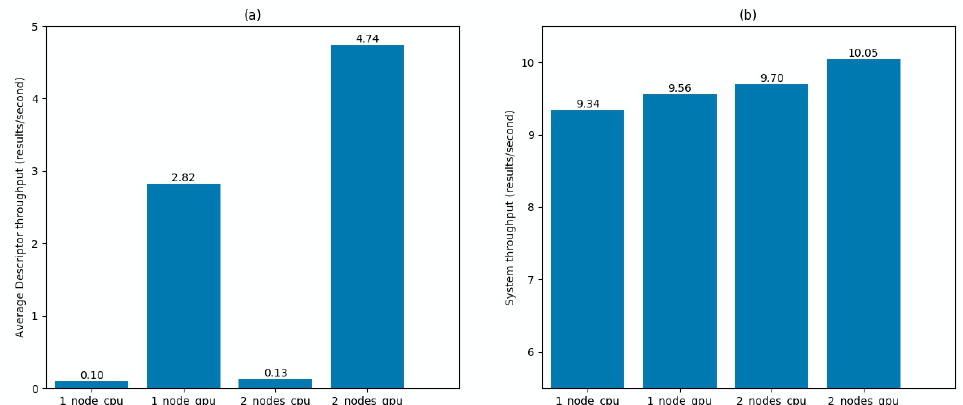
Figure 9. Scalability of six identical Descriptor chains using one or two nodes in both CPU and GPU modes. ( a ) Average Descriptor throughput. It indicates the number of feature updates per second averaged among the six Descriptor chains. ( b ) System throughput. It indicates the number of output messages per second.